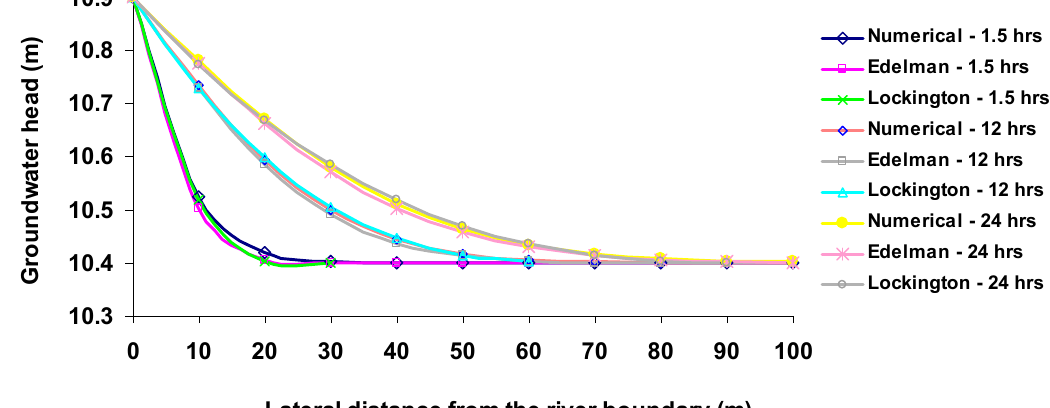
Figure 3. Groundwater head versus lateral distance from river at specific times for numerical and analytical solutions (Edelman [31] and Lockington [32]) for a semi-infinite unconfined aquifer.